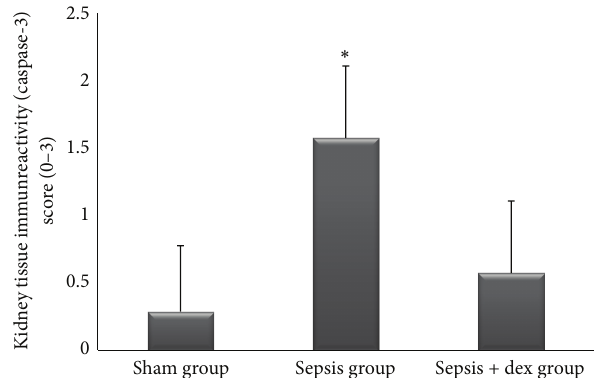
Figure 7: Histological lung injury scores in experimental groups. ∗ 𝑃 < 0.05 compared with sham and sepsis + dex groups.